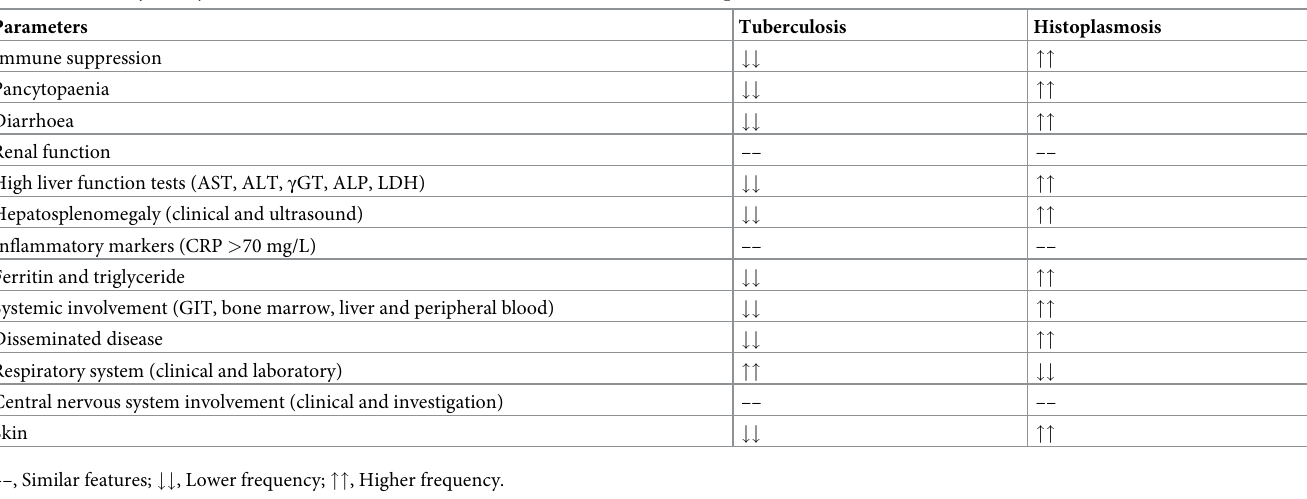
Table 3. Summary of major features associated with tuberculosis and disseminated histoplasmosis in context of HIV infection.